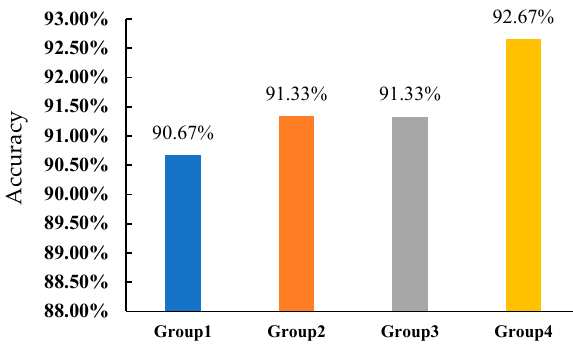
Figure 11. Accuracy Change of Fault Prediction Algorithm.